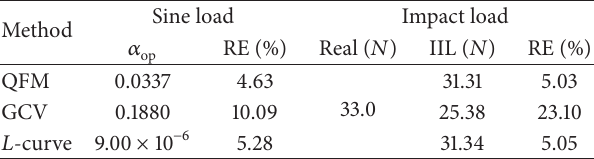
Table 6: Relative results of laboratory experiment of MIMO system.